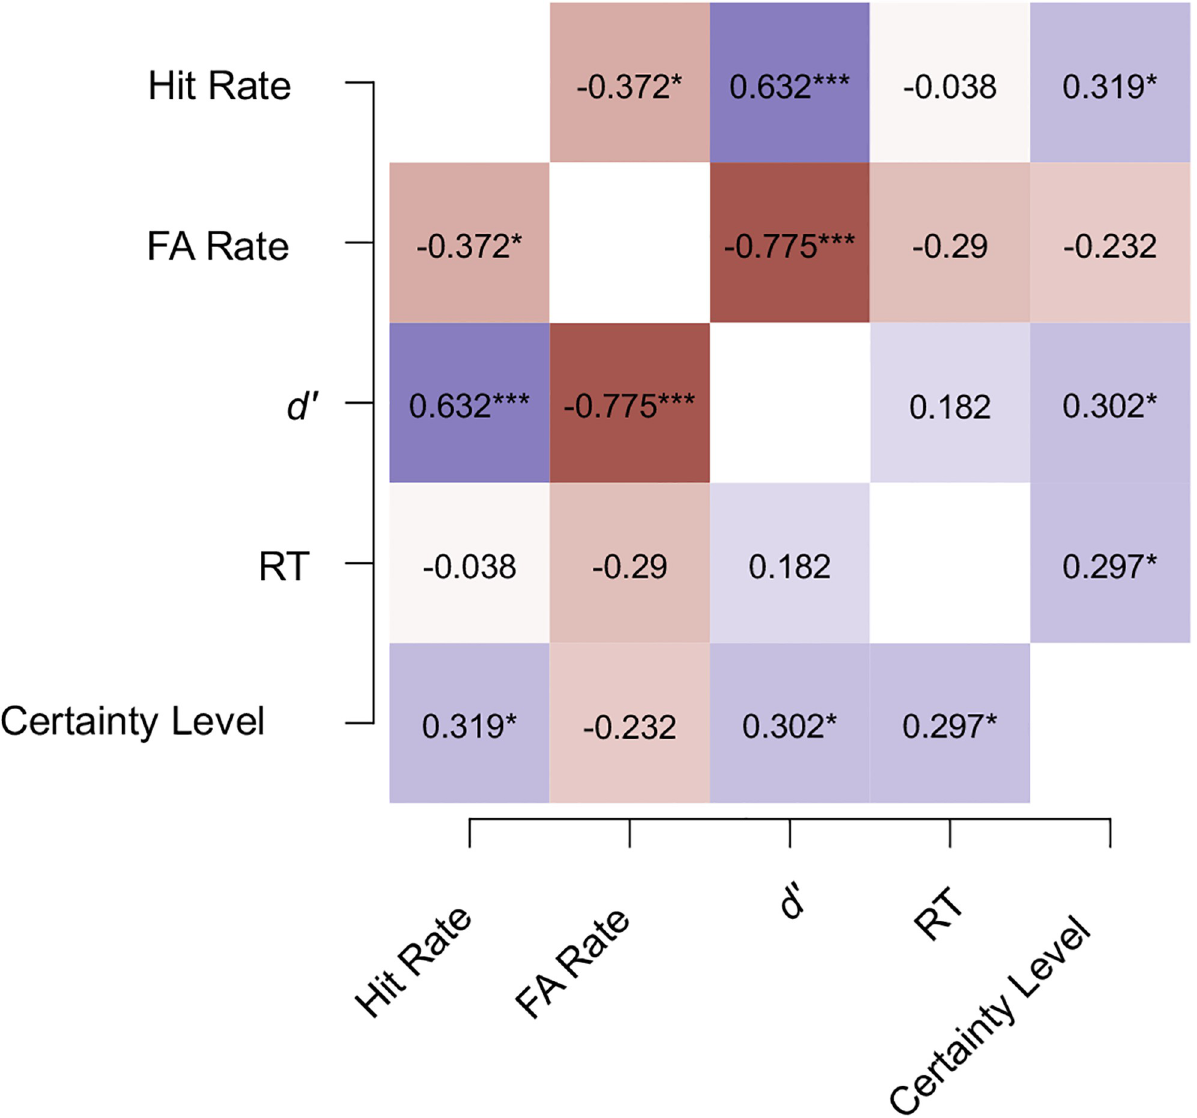
Fig 3. Heatmap of the correlations between the measures in Experiment 1a. The heatmap depicts Kendall’s tau correlations between the measures of Hit rate, False alarm (FA) rate, the sensitivity index ( d ’), reaction time (RT), and the subjective certainty level averaged for each participant. Blue and red colors correspond to positive and negative correlation coefficients, respectively. The saturation of colors illustrate the magnitude of the correlation coefficient. * p < 0.05, ** p < 0.01, *** , p <